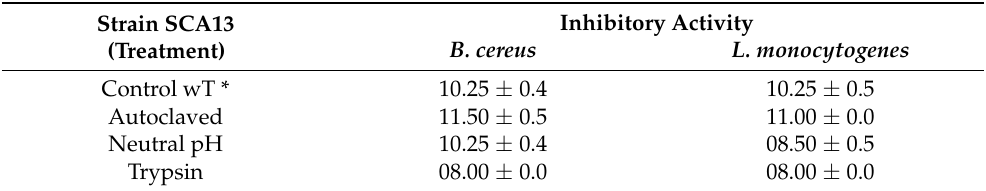
Table 4. Treatment results. Mean and standard deviation of growth inhibition halos (with 10 mm). * SCA13 without